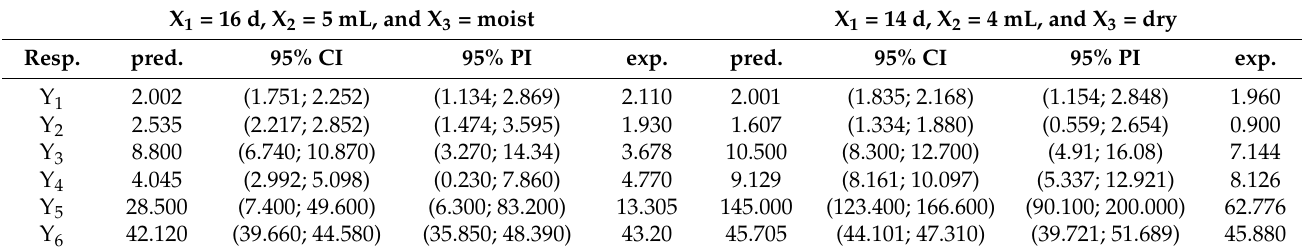
Table 5. Experimental validation of the mathematical